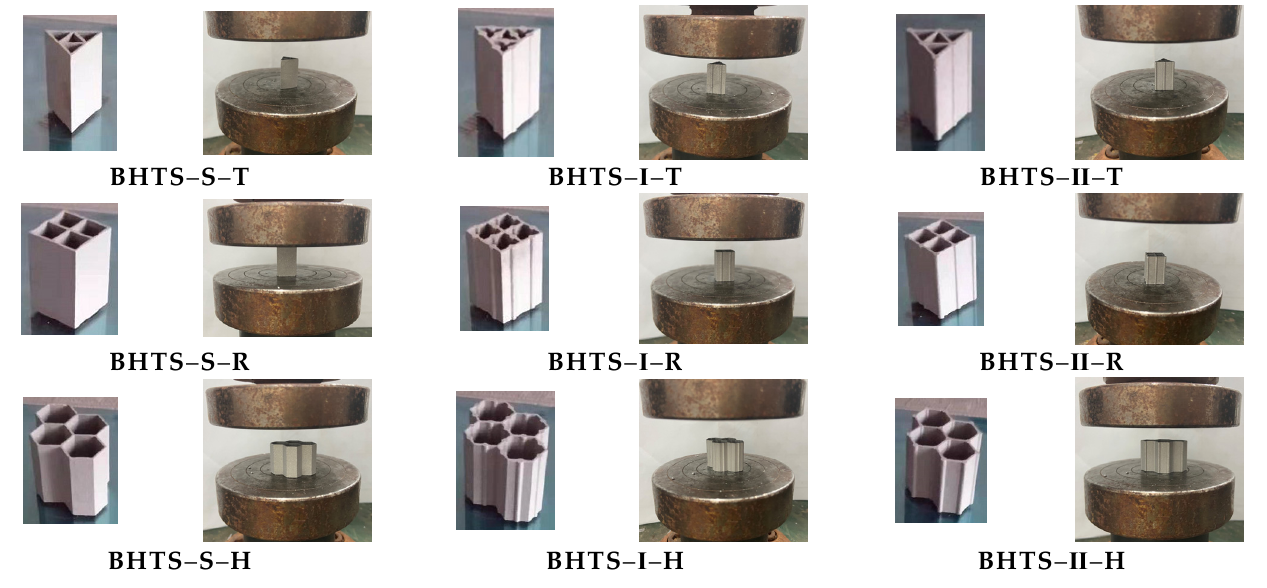
Figure 4. BHTS loading.